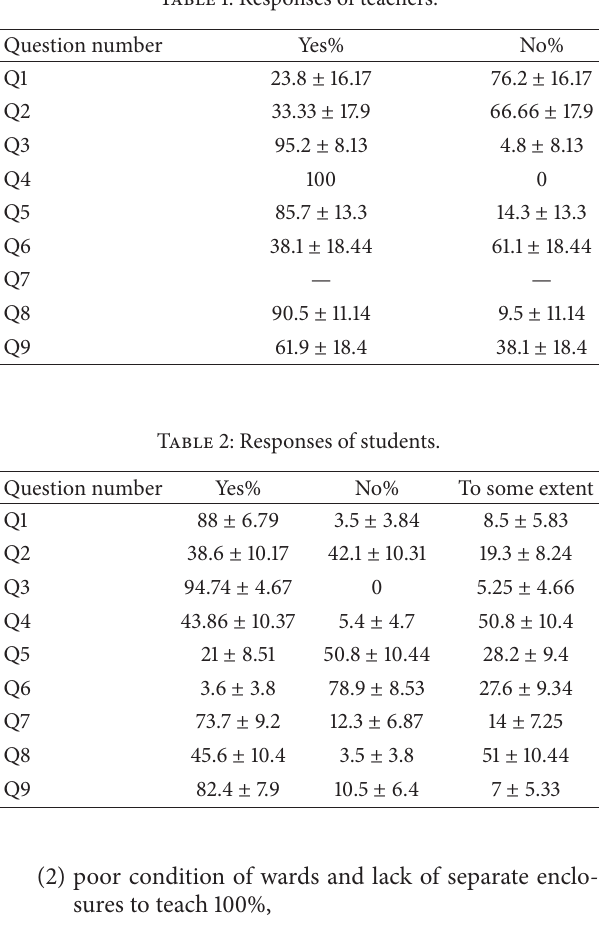
Table 1: Responses of teachers.